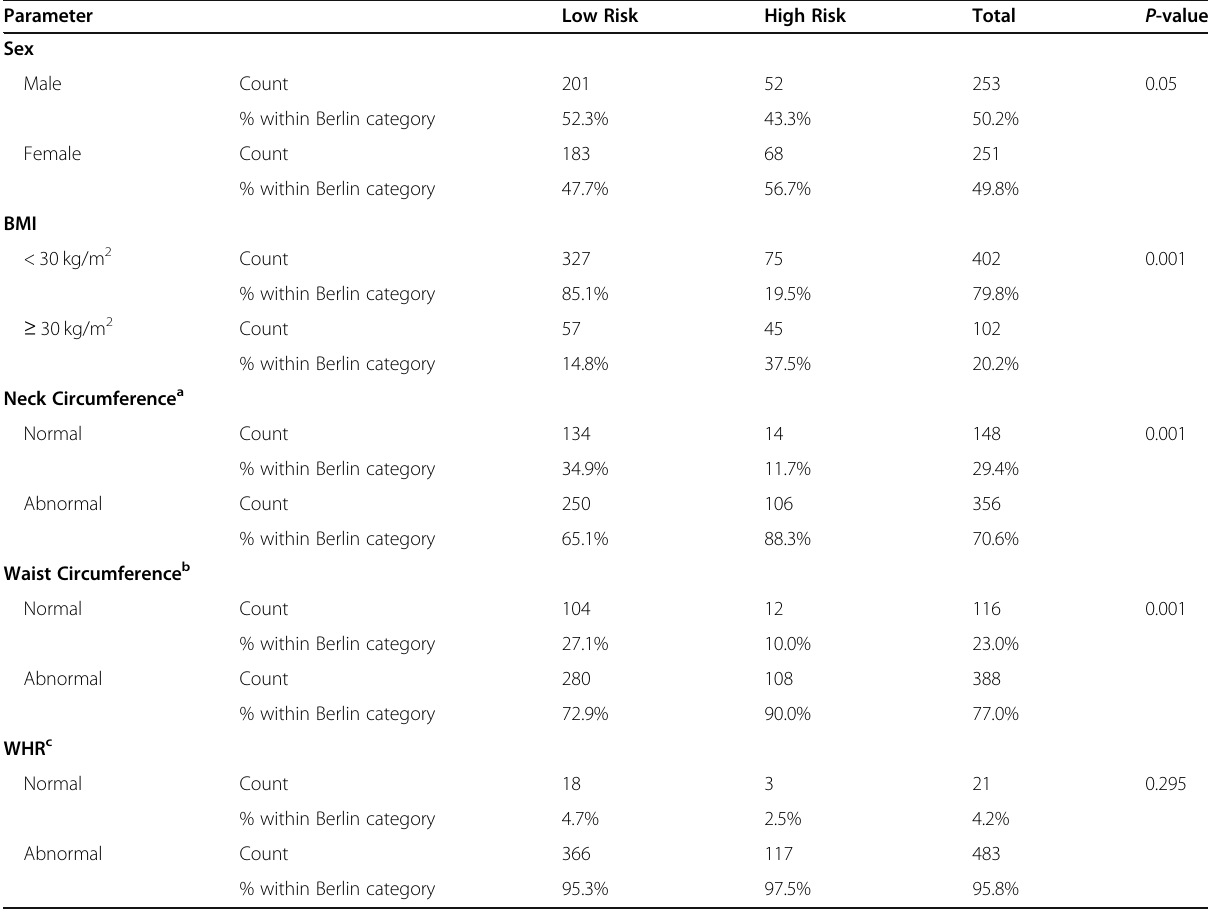
Table 2 Descriptive statistical analysis of various anthropometric parameters in study patients